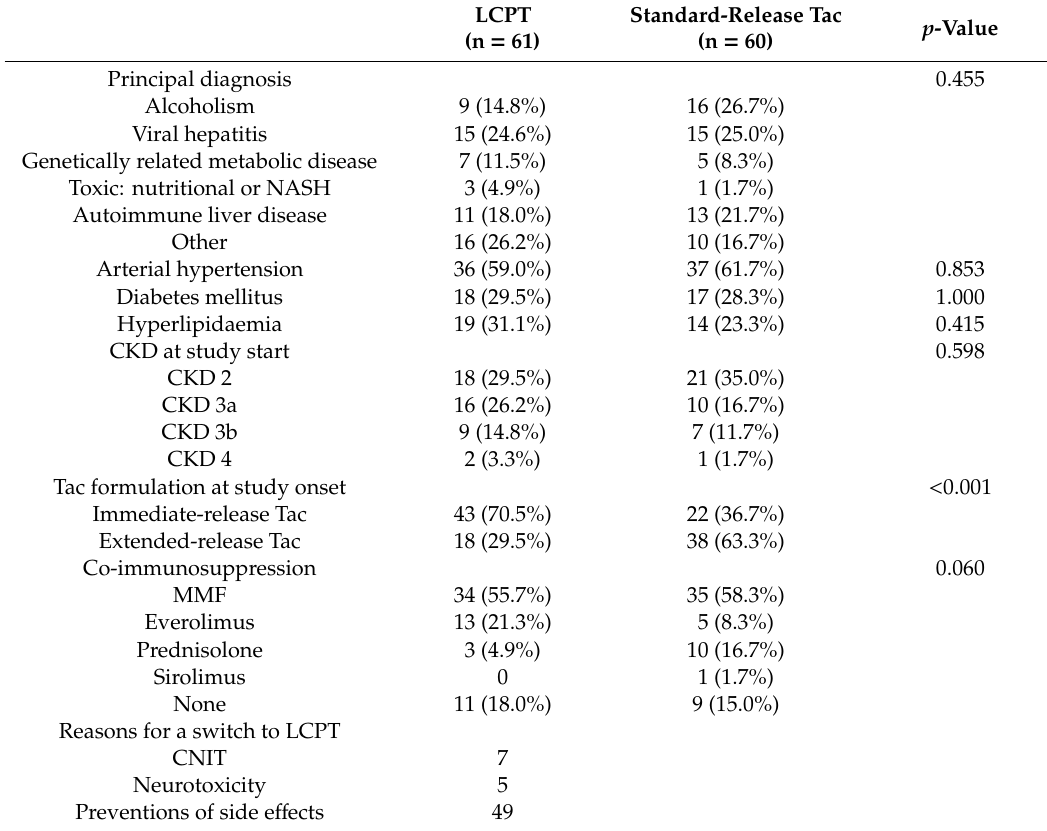
Table 2. Underlying diagnoses for LTx, comorbidities and immunosuppression at study